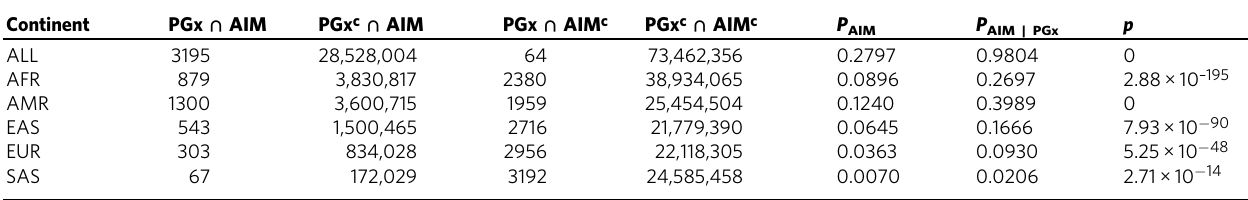
Table 2 Global distributions of AIM and distributions of AIM in pharmacogenomic loci.